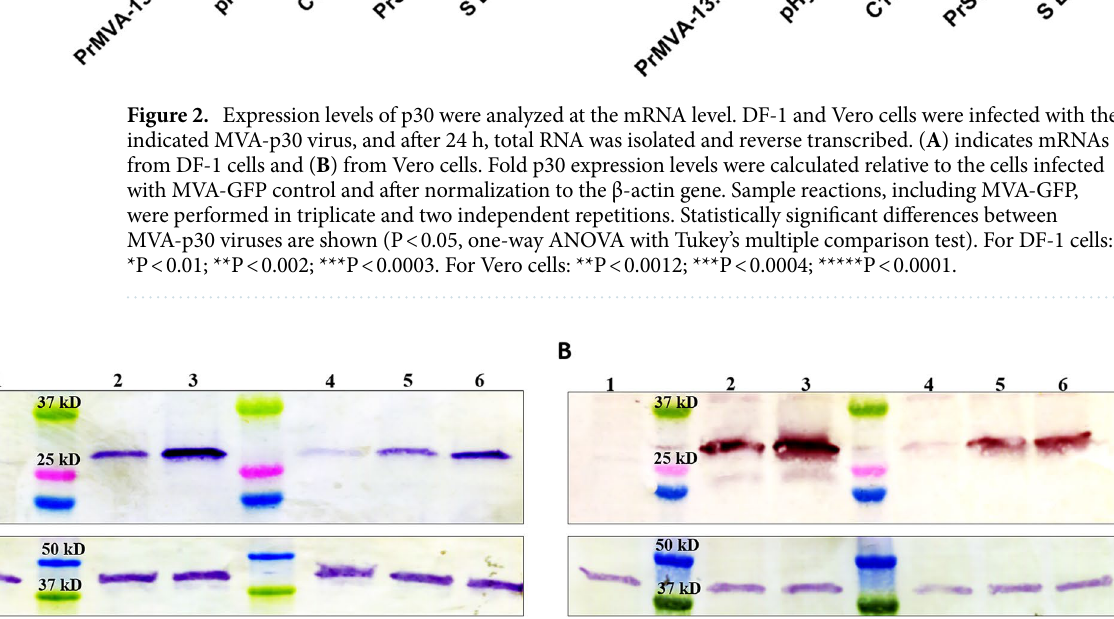
Figure 3. Detection of p30 protein expression by immunoblotting assay. Monolayers of DF-1 and Vero cells were infected with each MVA-p30 virus at an MOI of 5, and then total protein extraction was performed at 24 h p.i., and extracted proteins were subjected to SDS-PAGE followed by western blot analysis. ( A ) indicates proteins from DF-1 cells and ( B ) from Vero cells. The order is as follows, MVA-GFP control (1), PrMVA-13.5 (2), pHyb (3), S E/L-C13L (4), PrS5E (5), and S E/L (6). A parallel blot incubated with a ß-actin specific monoclonal antibody served as loading control. Molecular masses of marker proteins are indicated. Full-length blots are presented in Supplementary Fig.